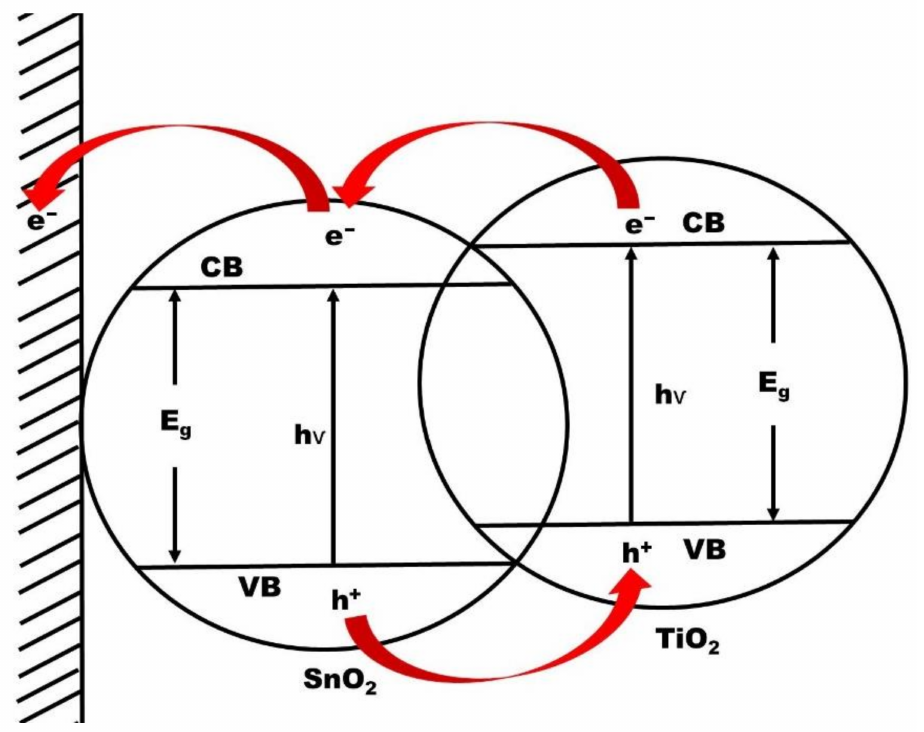
Figure 10. Scheme for charge carrier transfer from TiO 2 to SnO 2 conduction